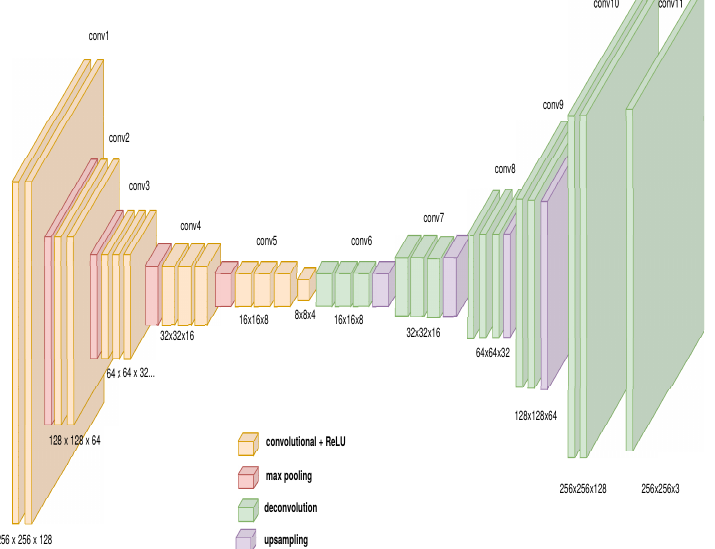
Figure 15. Model features for the GAN’s generator, which estimates the virtual samples from real inputs.